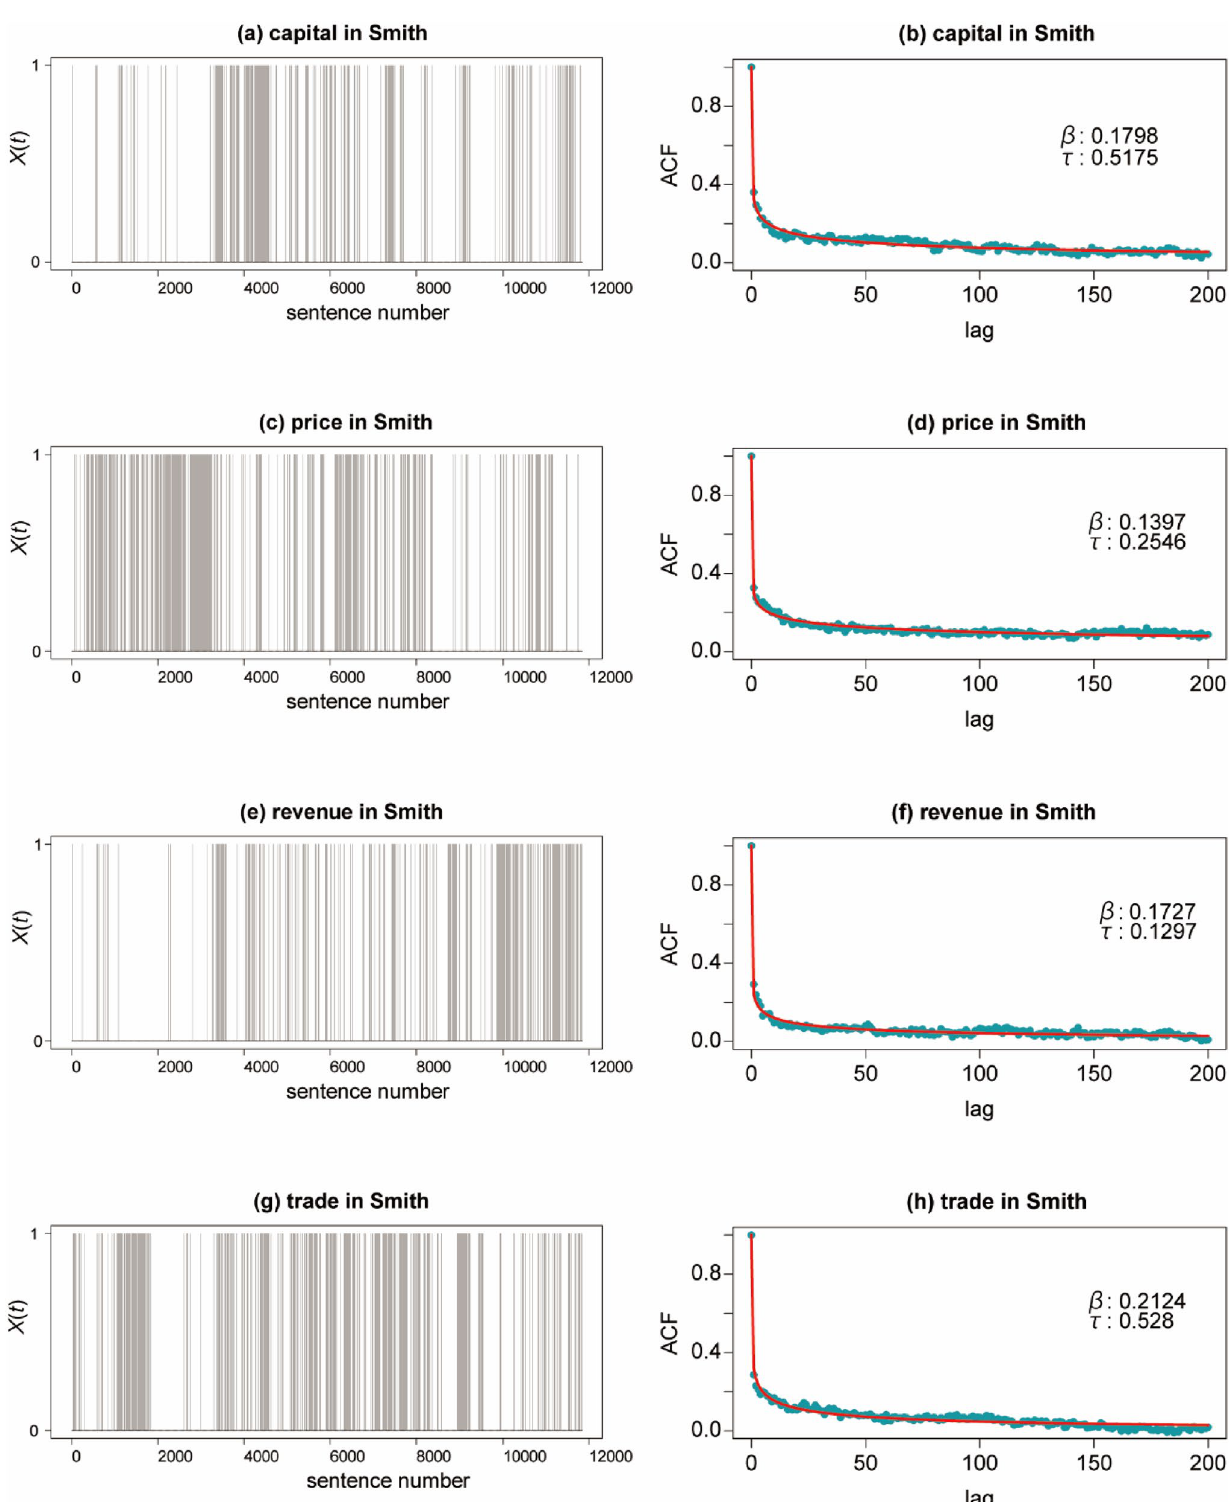
cific and bursty manner, and long-range dynamic correlations are seen in the plots in the left and right columns, respectively. Red curves in the plots in the right column show best fitted results by use of the stretched exponential functions [7–9] optimized param- eters of which are displayed in each of the